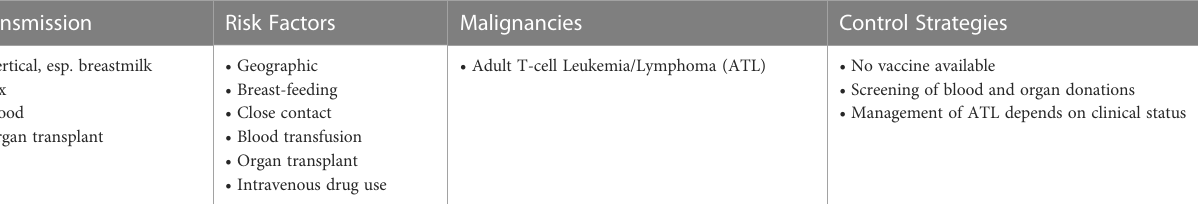
TABLE 5 HTLV-1 infection in